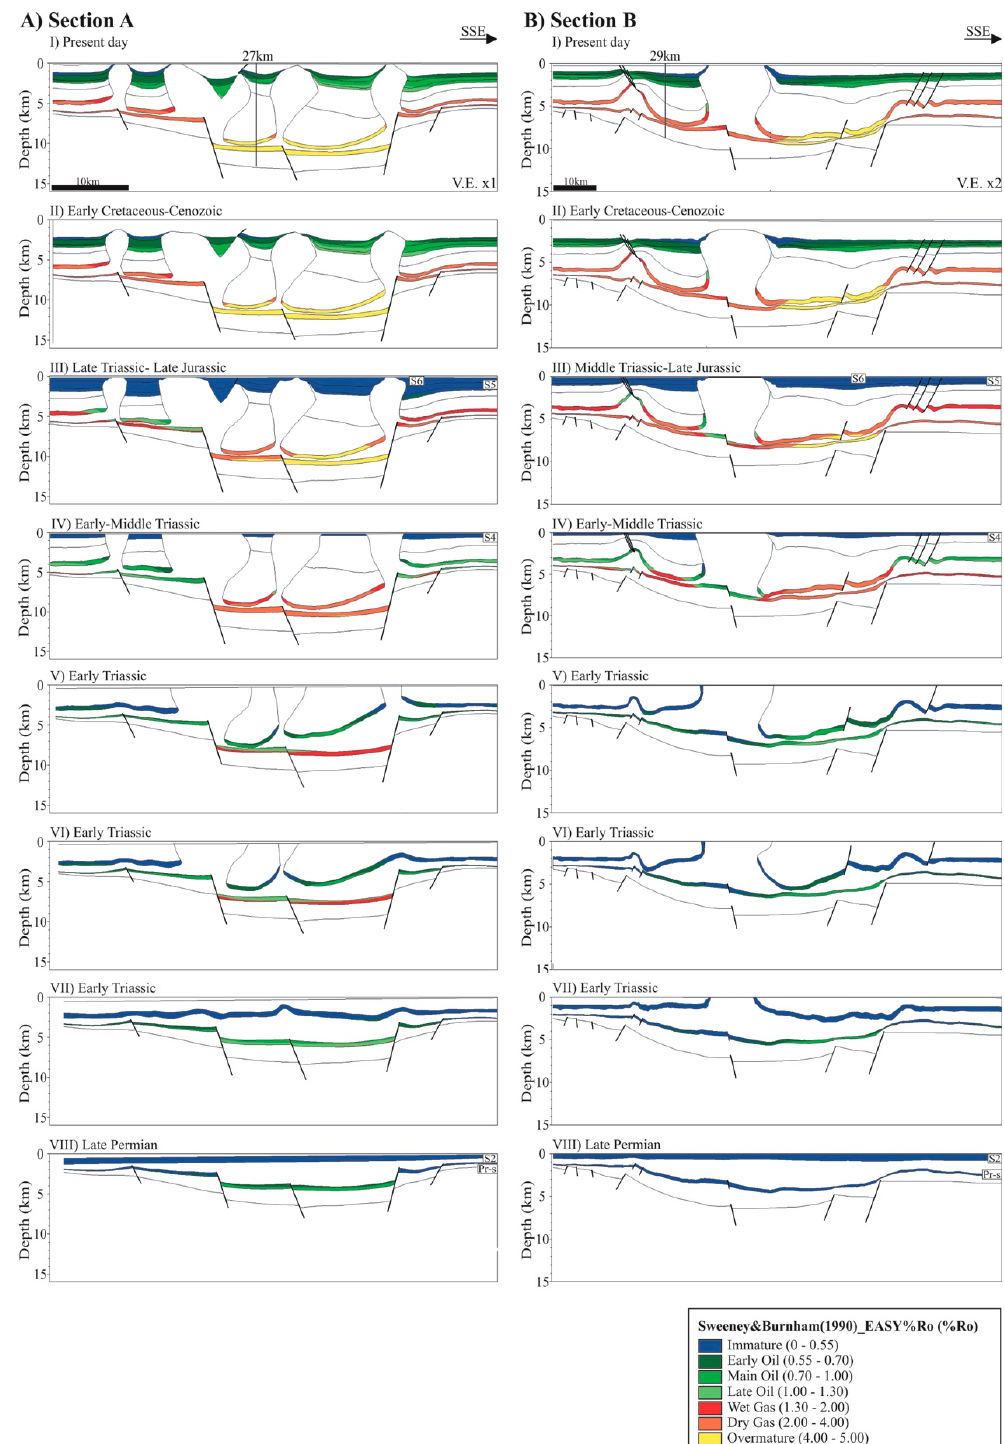
Figure 9. Source rock maturation through time in ( A ) section A in the central sub-basin, and ( B ) section B in the eastern sub-basin. Figure 1B shows the location of the sections.